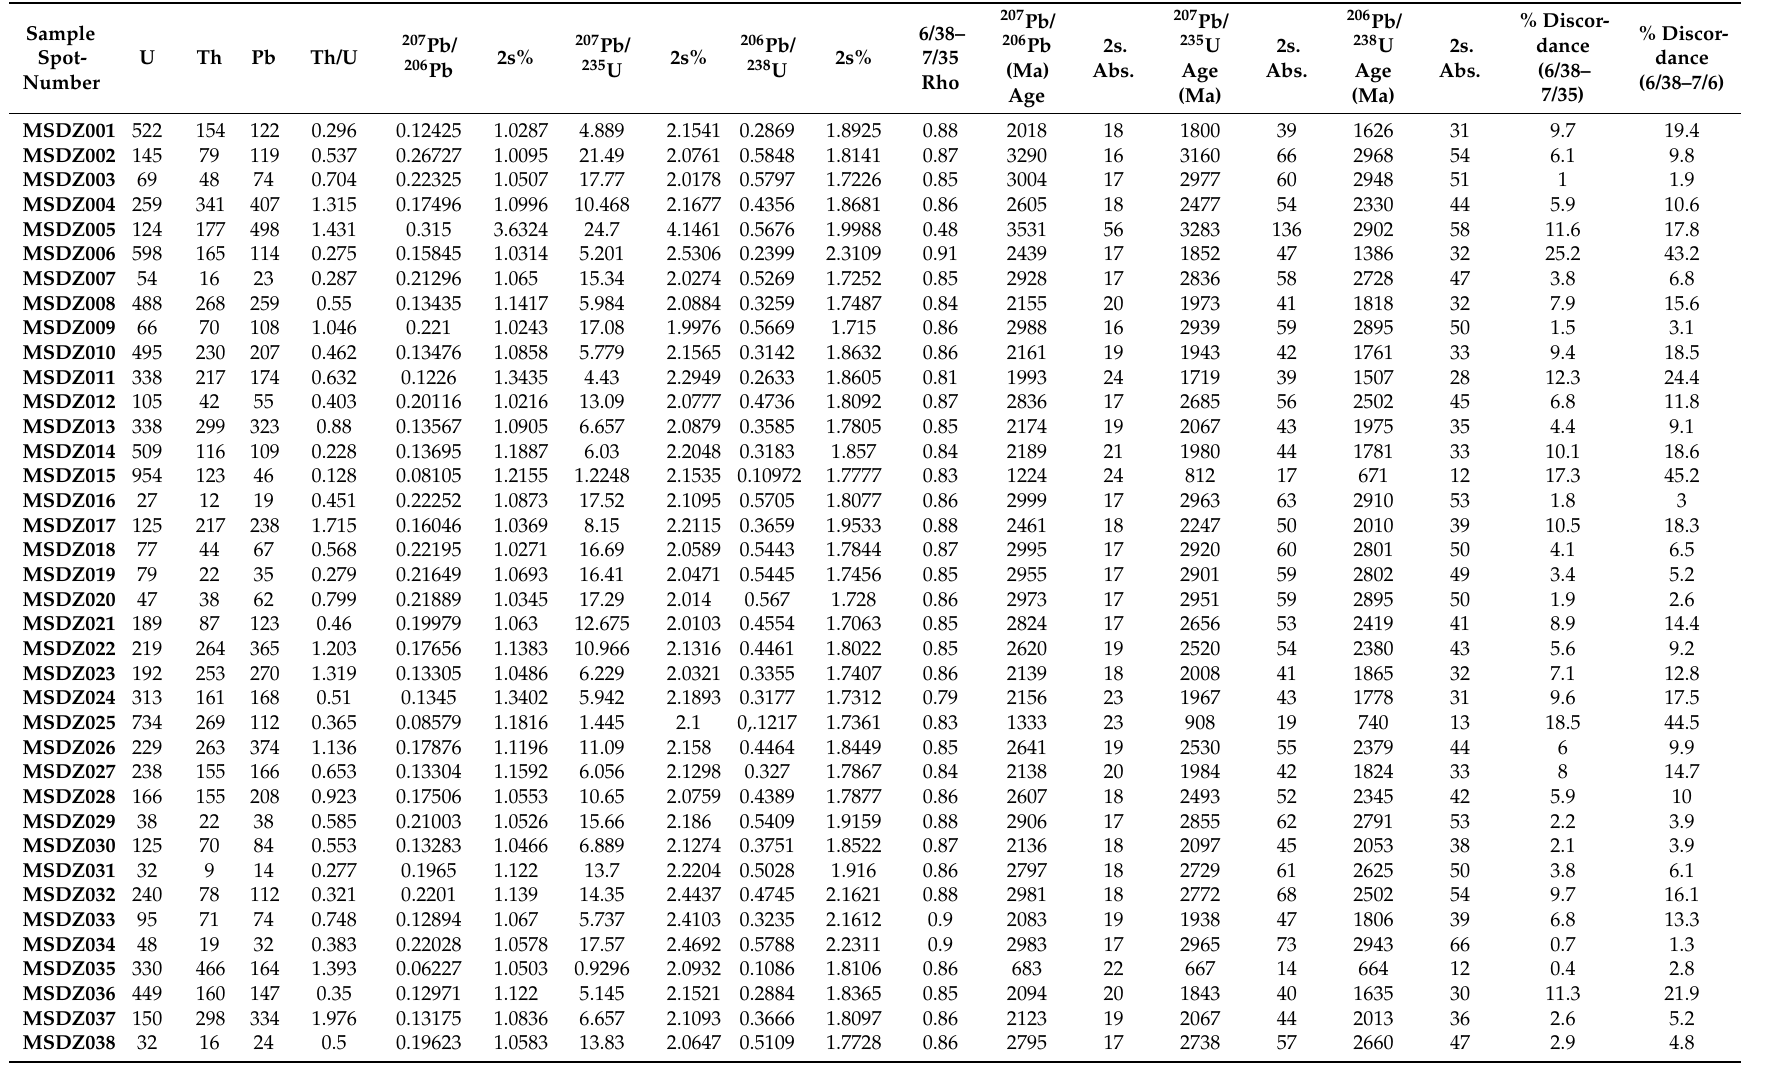
Table 3. U, Th, and Pb abundance (in ppm), isotopic geochemical data, and U-Pb core ages (in Ma) for the southern Meiganga detrital zircons. Sample